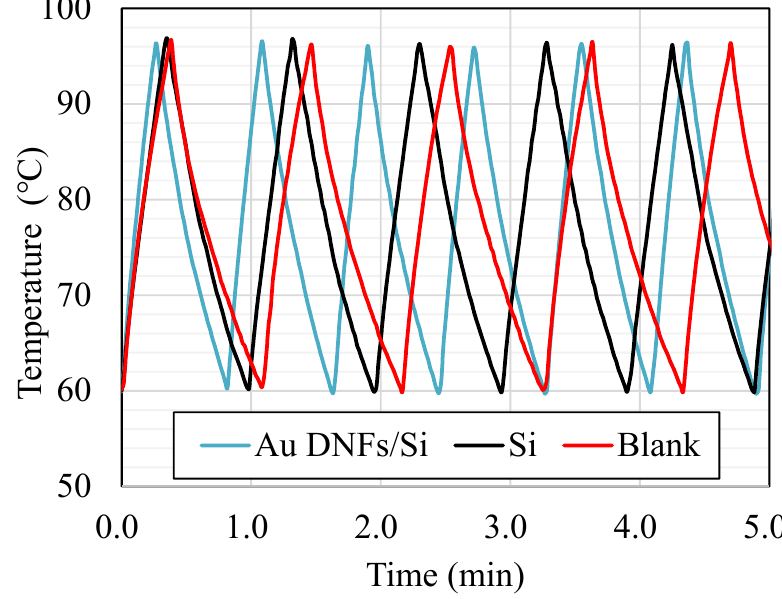
Figure 4. Cyclic temperature recorded in the PCR system.